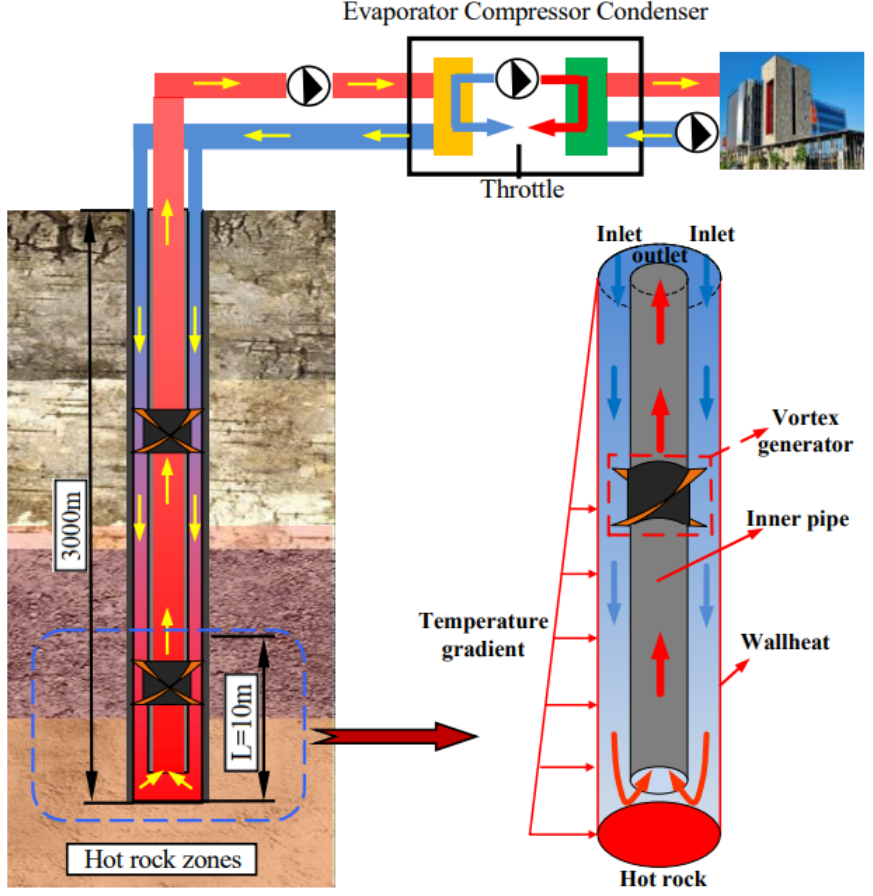
Figure 1. Schematic diagram of working principle of the coaxial borehole heat exchanger.